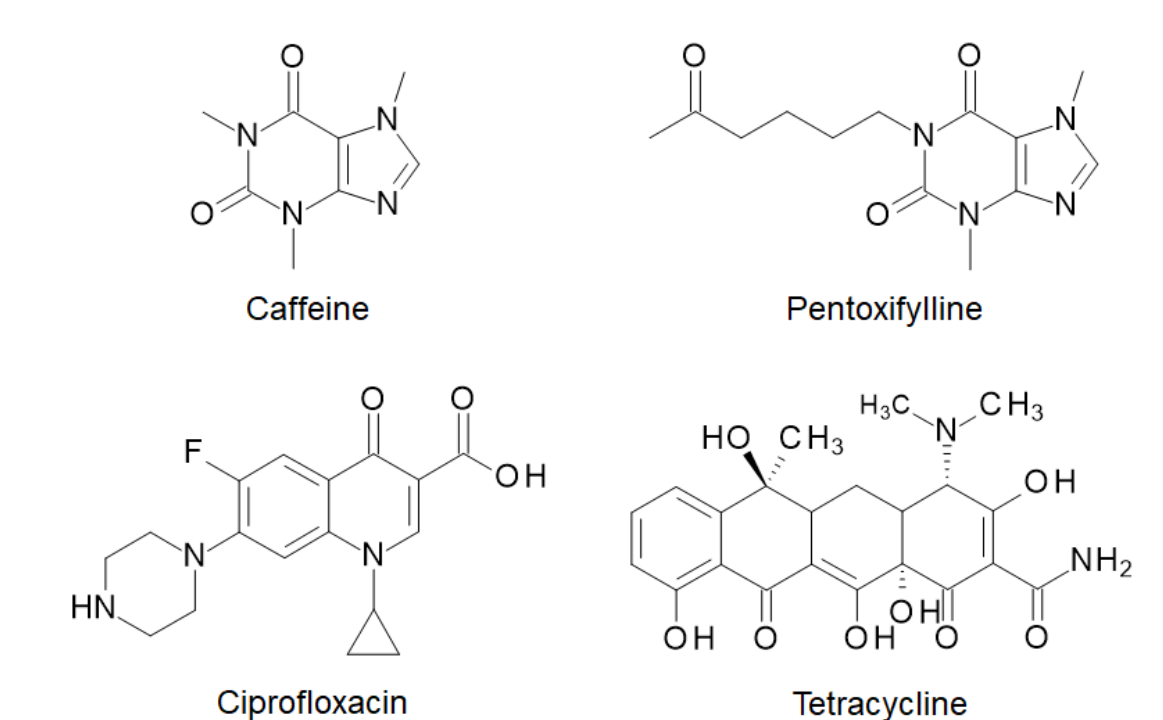
Figure 6. Chemical structures of studied compounds. Top, xanthines: caffeine and pentoxifylline; bottom, antibiotics: ciprofloxacin and tetracycline.